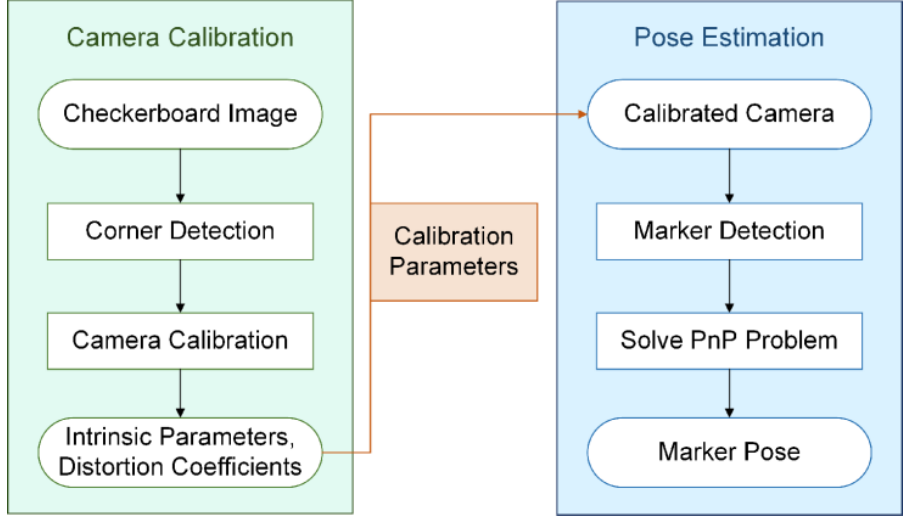
Figure 2. Overview of the pose estimation approach.